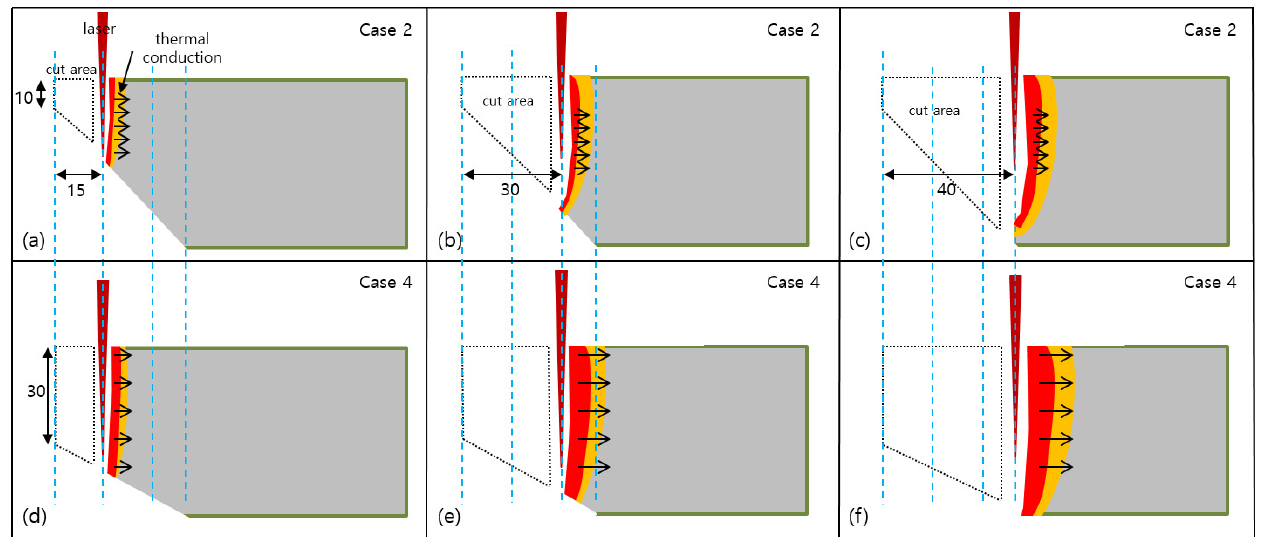
Figure 15. Visualization of thermal conduction according to the cut position of the specimen. (side- view) ( a ) case 2: 15 mm cut point, ( b ) case 2: 30 mm cut point, ( c ) case 2: 40 mm cut point, ( d ) case 4: 15 mm cut point, ( e ) case 4: 30 mm cut point, and ( f ) case 4: 40 mm cut point.